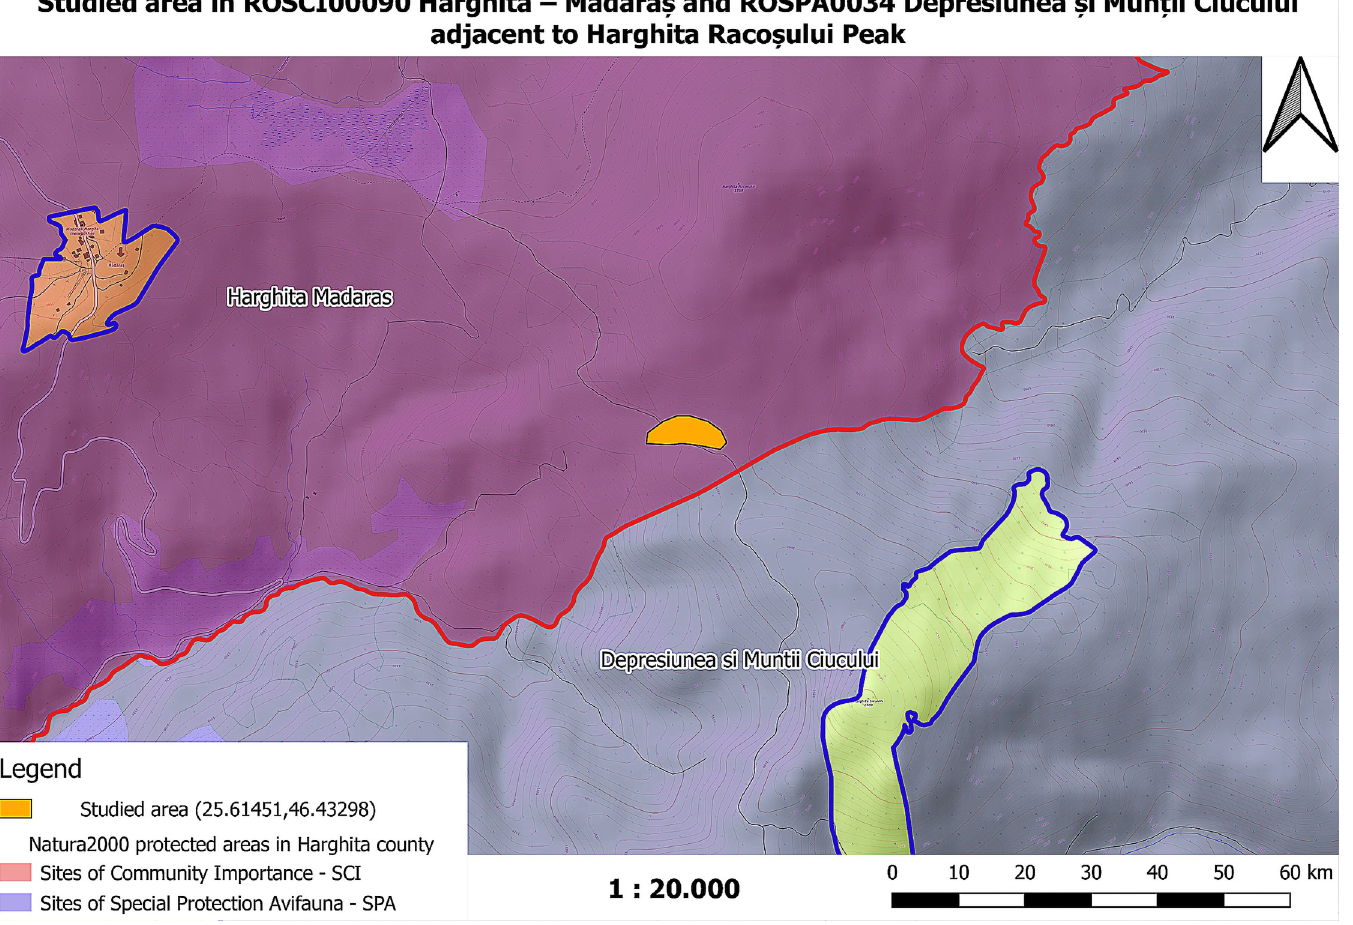
Fig 15. The distribution map of × Pseudorhiza nieschalkii nothosubsp. siculorum in Harghita–M ă d ă ra ş protected area that yields the holotype and only known plant (map used by permission of National Agency for Protected Areas Harghita Territorial Service). sprinkled with purple dots and streaks, spreading laterally and horizontally, relative to the loose hood formed by the median sepal and lateral petals. Basal bracts 16 millimetres, exceed- ing flowers, upper floral bracts 14 millimetres, both exceeding ovaries, top bracts lightly purple tinged with anthocyanin pigments.